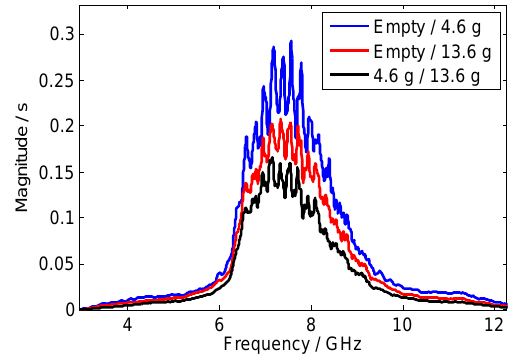
Figure 13. Convolution of the UWB magnitude spectra from Fig.